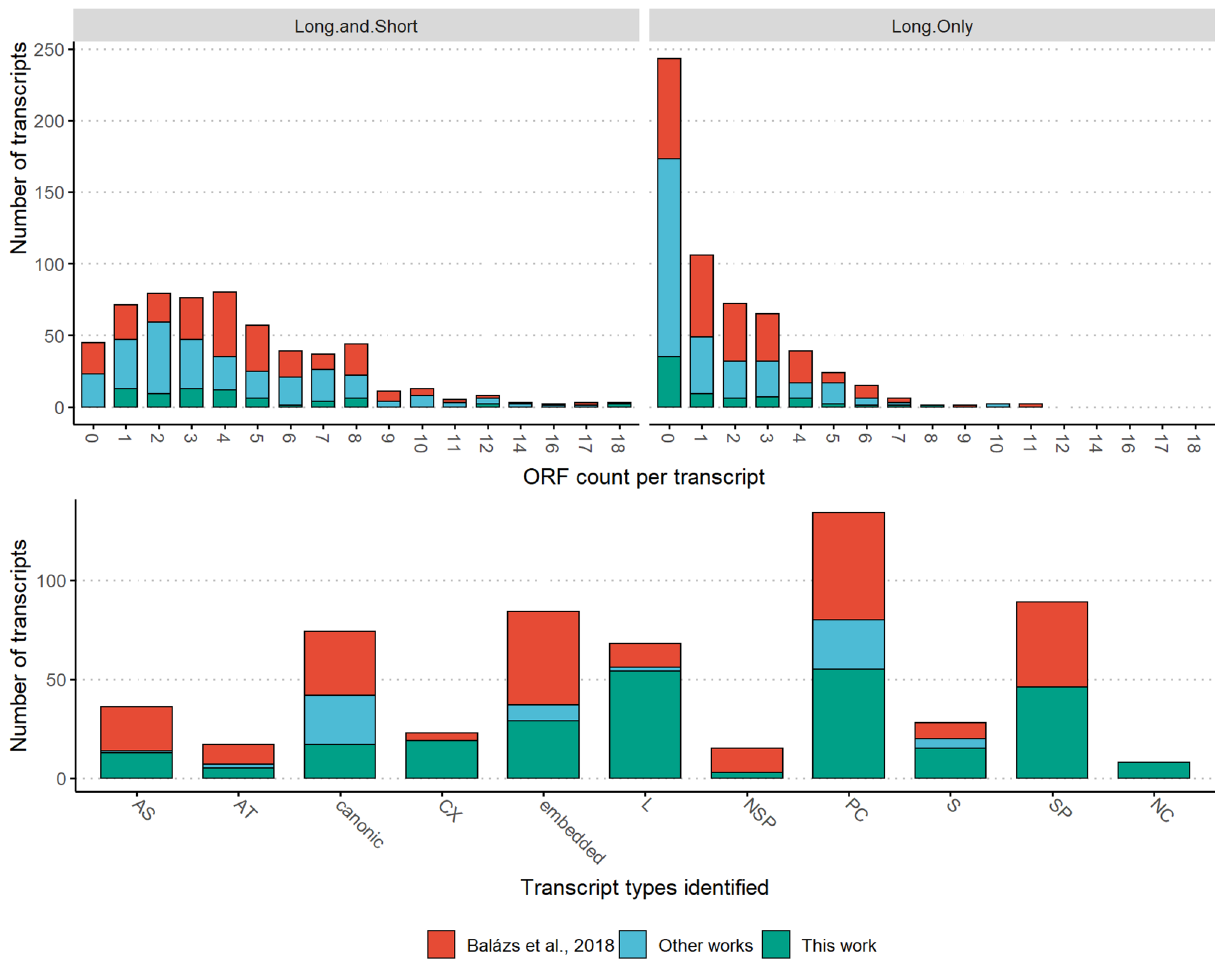
Figure 6. Upper panels: The frequency of transcripts, according to the number of ORFs they encompass (Long, or Long + Short, according to 35 ). Lower panel: number of transcripts identified according to transcript categories. Transcripts described in this work are colored with blue, those that we described previously 40 are colored red, and those that we detected but were described in other works previously are colored